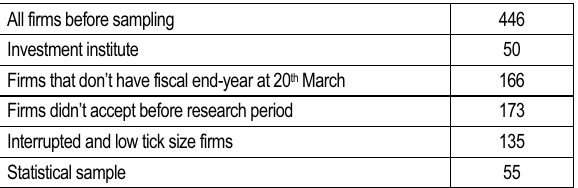
Table 1. The result of